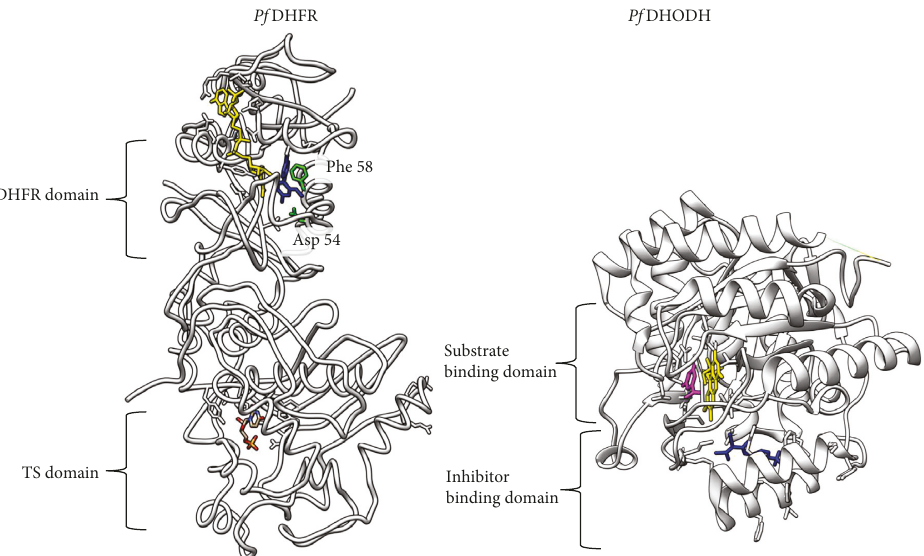
Figure 1: Cartoon representation of the various domains of the Plasmodium falciparum DHFR-TS bifunctional enzyme and the Plas- modium falciparum DHODH proteins. Both enzymes are validated targets for the development of malaria